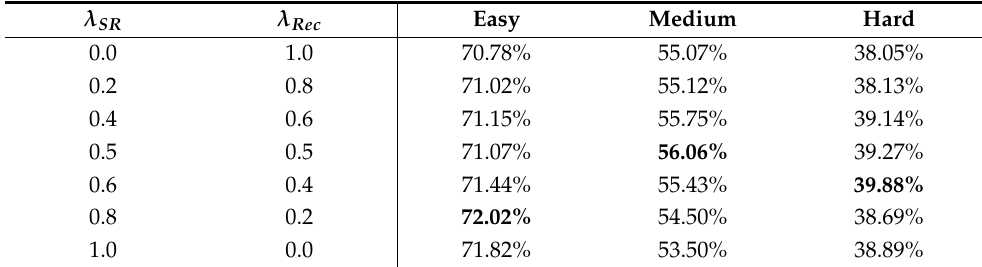
Table 2. Ablation study on the loss function for MTL.